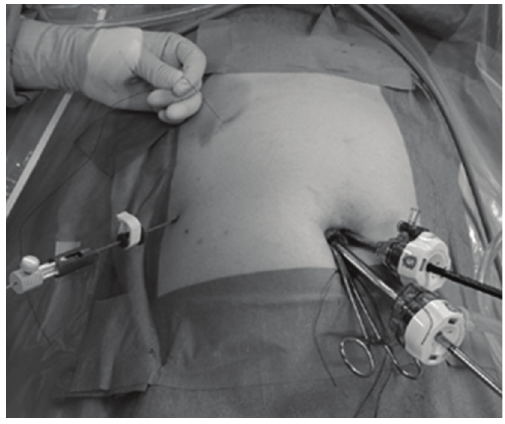
Figure 3: External view of 2-port LC. The surgeon operates one instrument and a 5mm flexible scope by herself, and the assistant pulls or pushes the fine loop retractor and the nylon suture. In this photograph, the assistant pulls a nylon suture with his left hand.